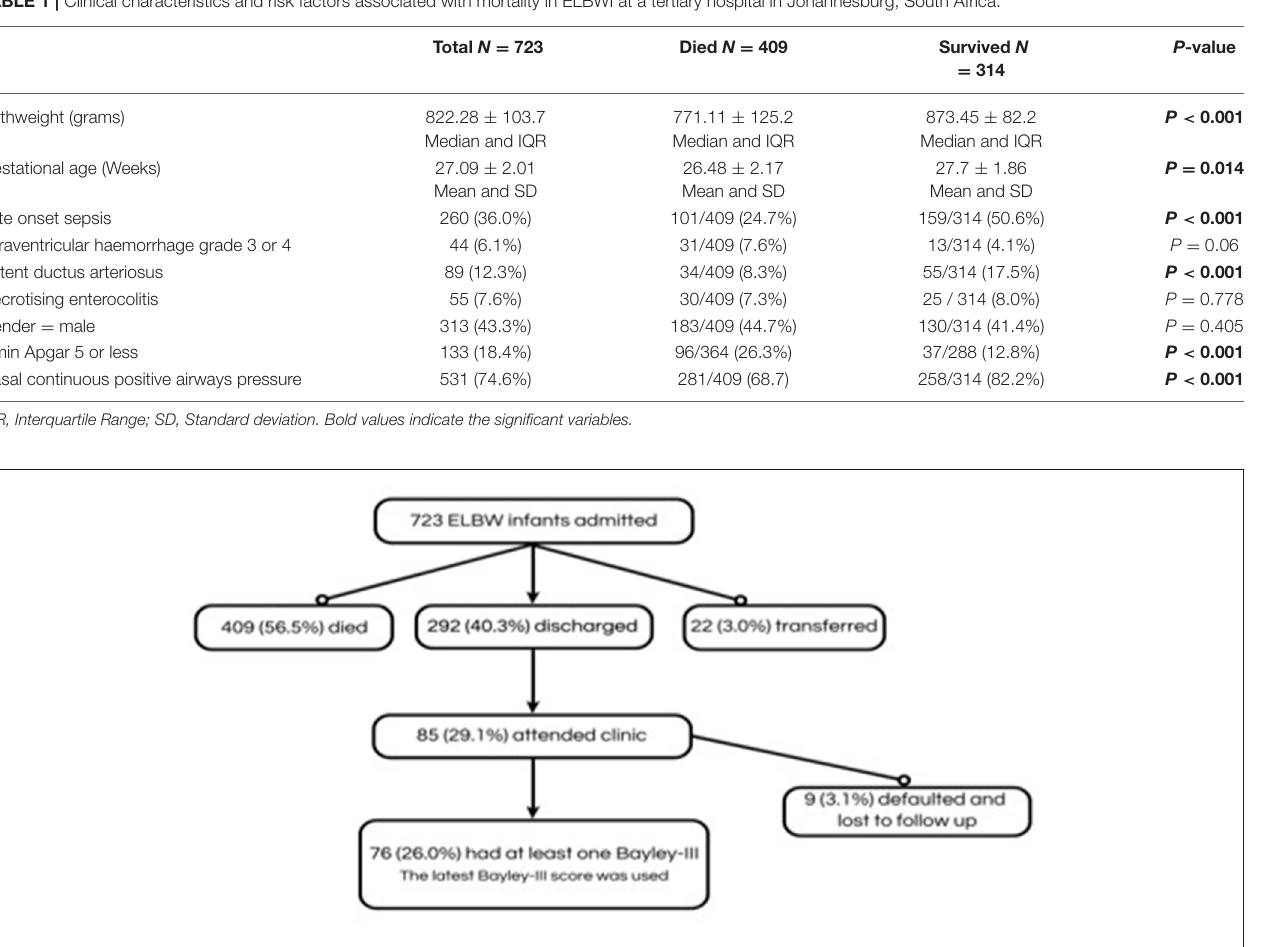
FIGURE 1 | Participants included in the study of neurodevelopmental outcomes of extremely low birth weight infants at a tertiary hospital in Johannesburg, South Africa, 1 July 2013 and 31 December